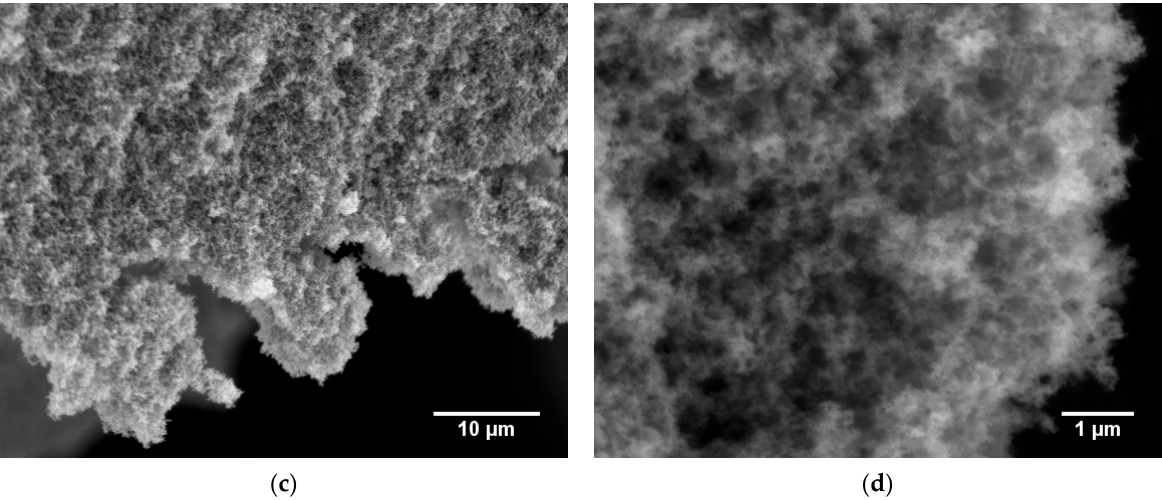
Figure 9. SEM micrographs of the ITO aerogel B samples as obtained directly after CPD ( a , b ) and after annealing at 400 °C for 2 h in air ( c , d ) at di ff erent magni fi cations.